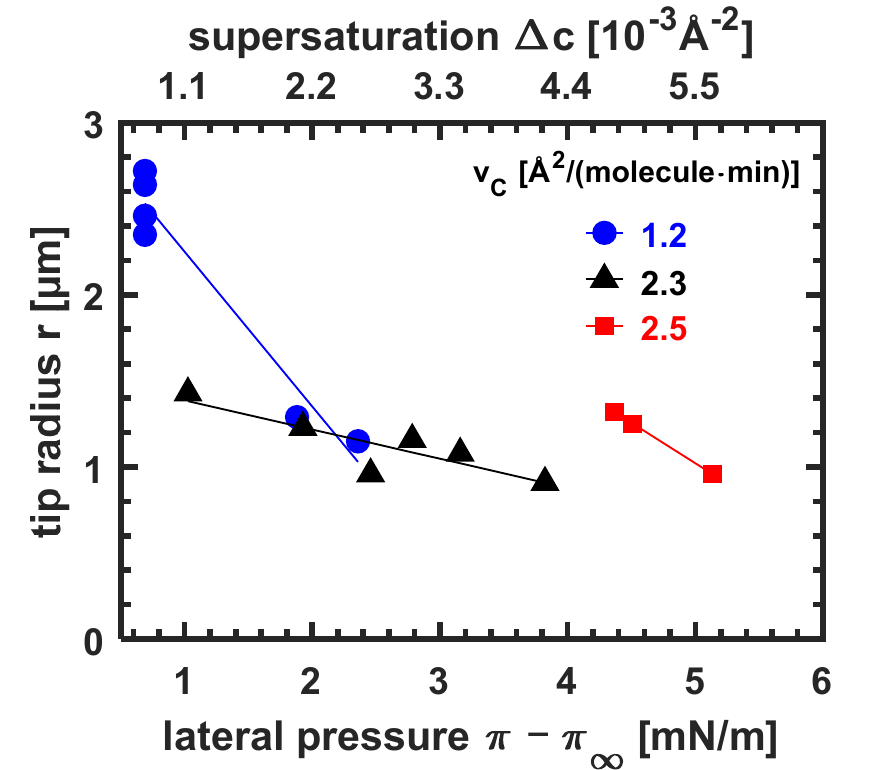
Figure 6. Tip radius r of domains from three different monolayers characterized by different com- pression velocity v C (indicated) as a function of the excess lateral pressure ∆ π = π − π ∞ , the lateral pressure above the LE/LC phase transition of erucic acid (cf. Figure 1) at equilibrium conditions.